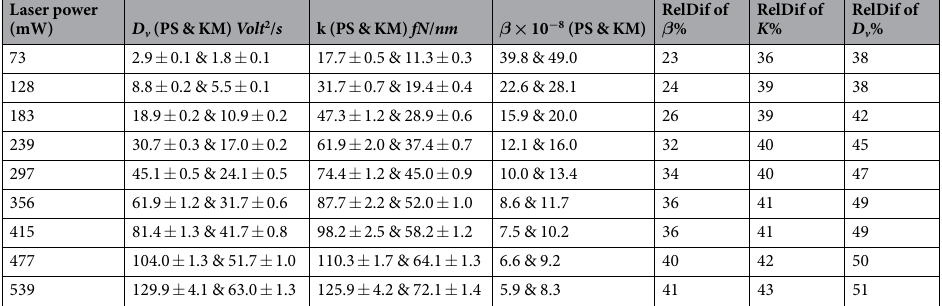
Table 1. Comparison of results from PS and KM methods.